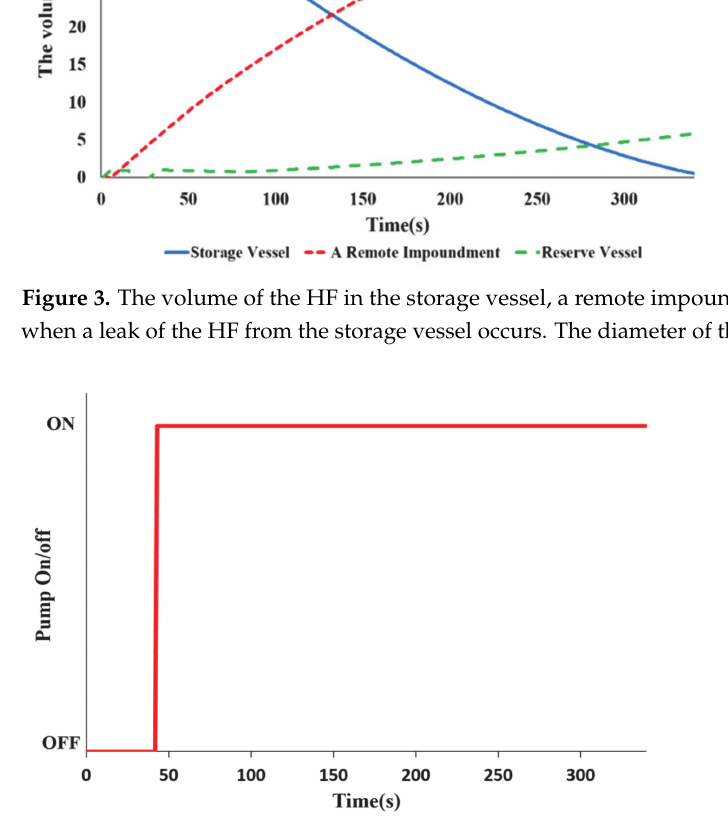
Figure 4. The operation of Pump 2 when the pump capacity is 50 m 3